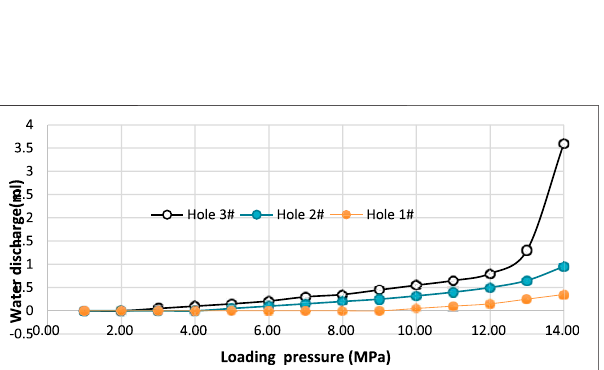
FIGURE 5 | Relationship between loading pressure and deformation of boreholes near the